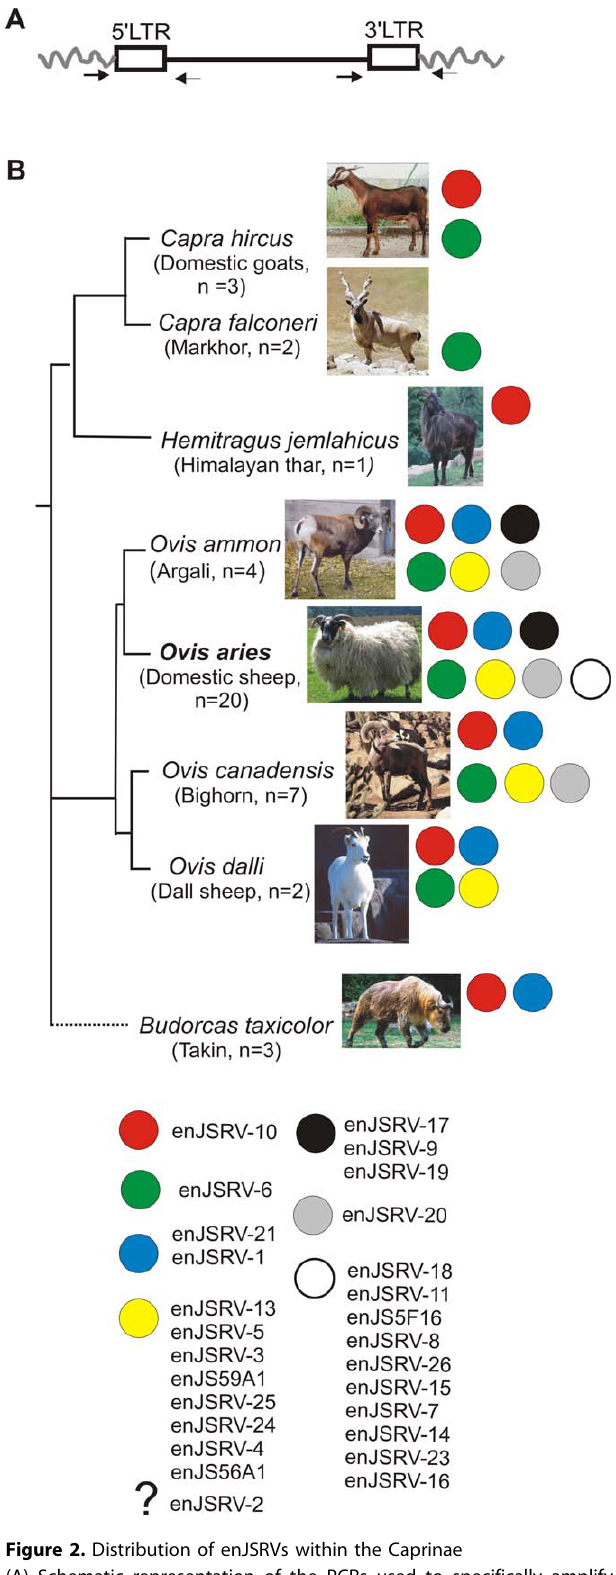
Figure 2. Distribution of enJSRVs within the Caprinae (A) Schematic representation of the PCRs used to specifically amplify each enJSRV provirus. (B) Simplified phylogenetic tree (branch length are not shown to scale) that shows representative species of the Caprinae subfamily used in this study. Common names and number of samples tested is indicated in parenthesis below the scientific names of each animal species.